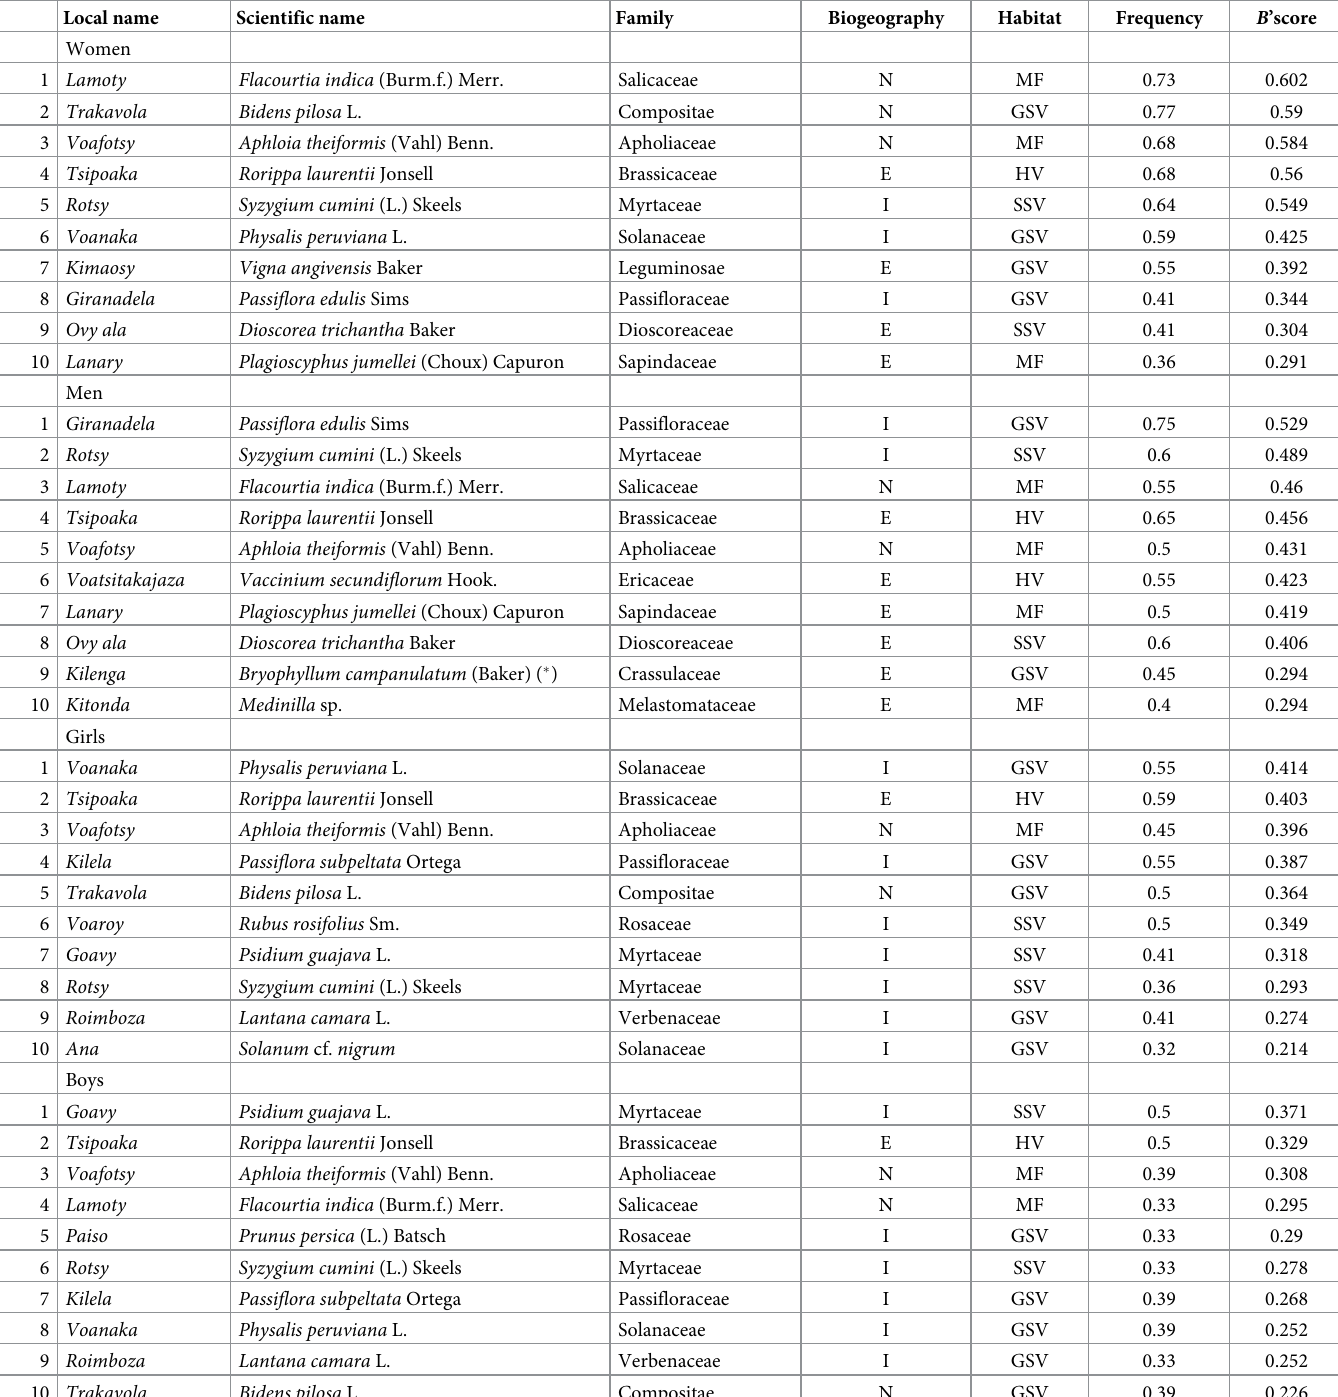
Table 1. Ten most salient WEPs species according to the B ’score